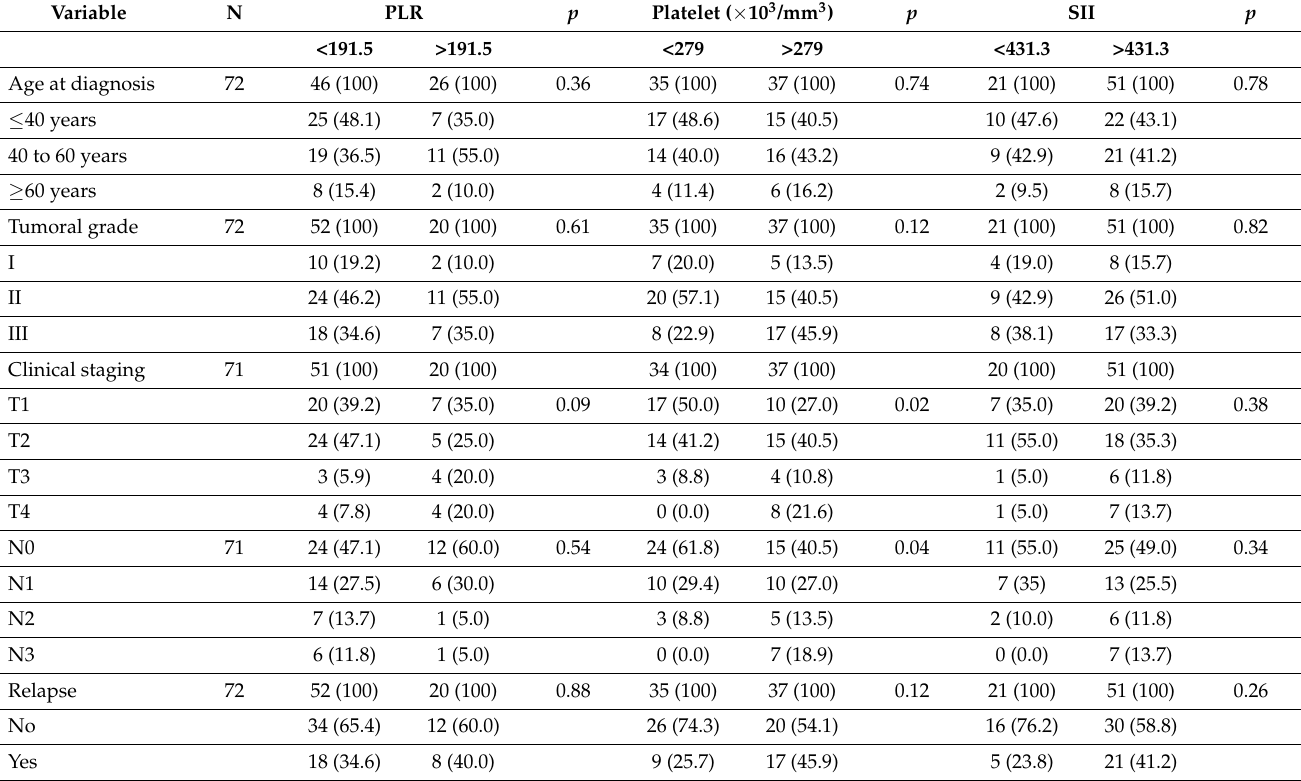
Table 3. Characteristics of patients, according to PLR, platelet count, and systemic index of inflamma- tion (SII)—death